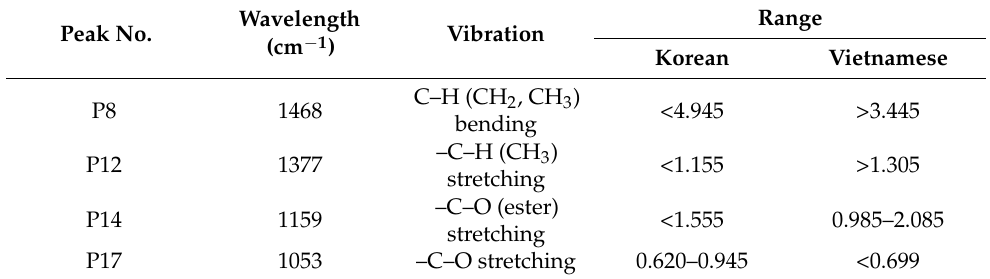
Table 5. Ranges of the indicator variables for Korean and Vietnamese